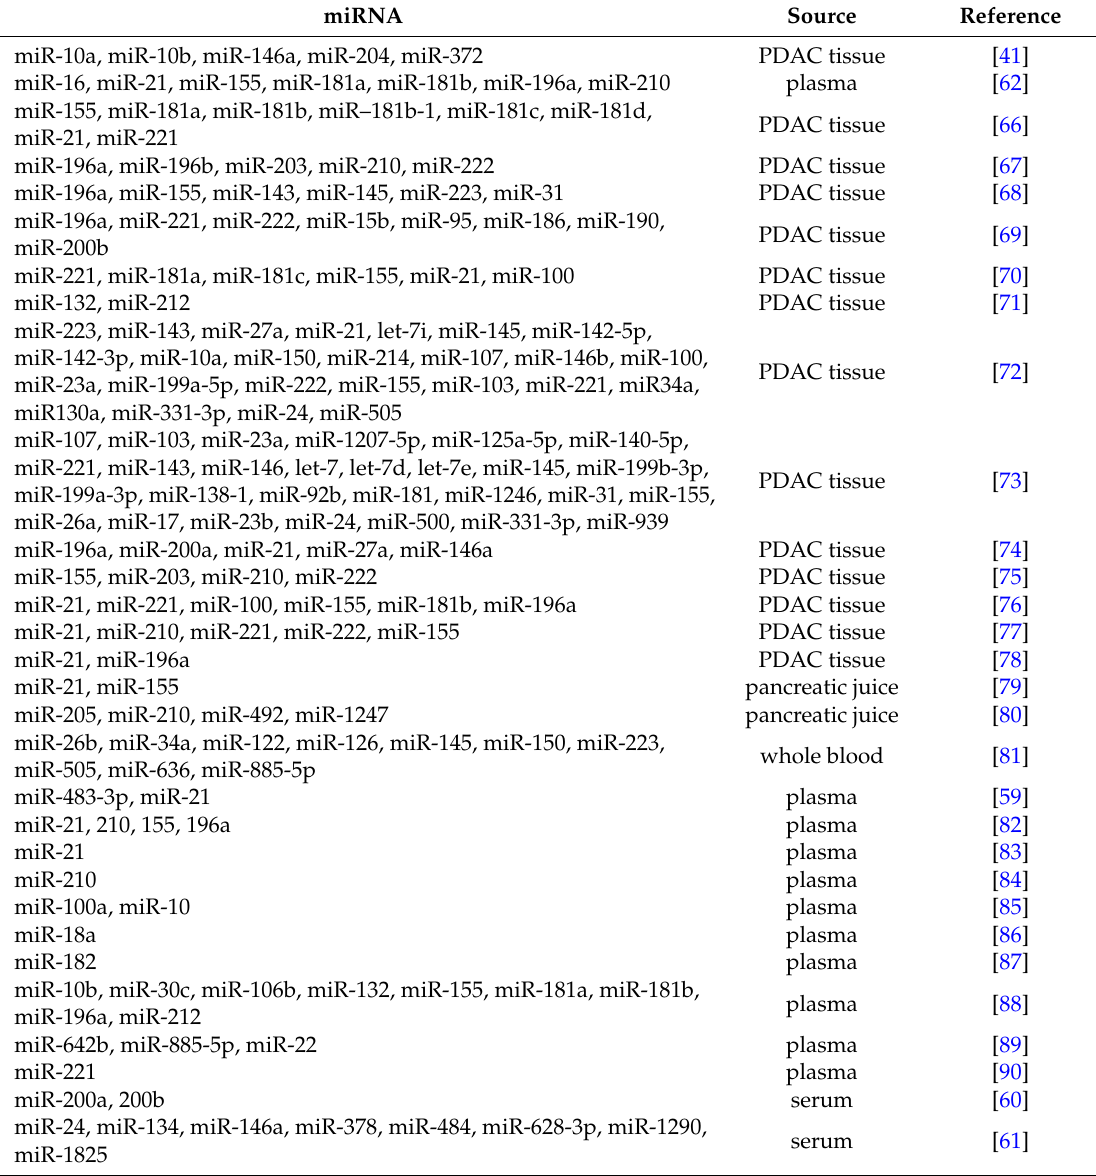
Table 1. miRNAs upregulated in pancreatic ductal adenocarcinoma (PDAC) compared to benign pancreatic pathology and/or healthy